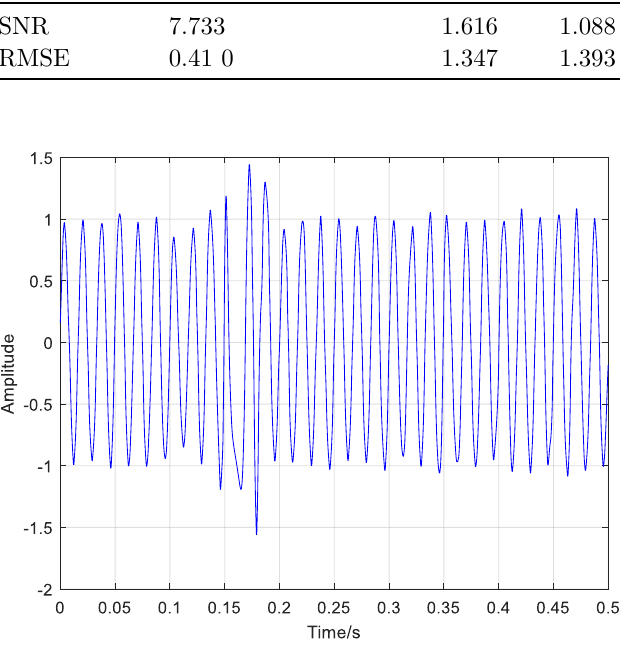
Fig. 5. Effective